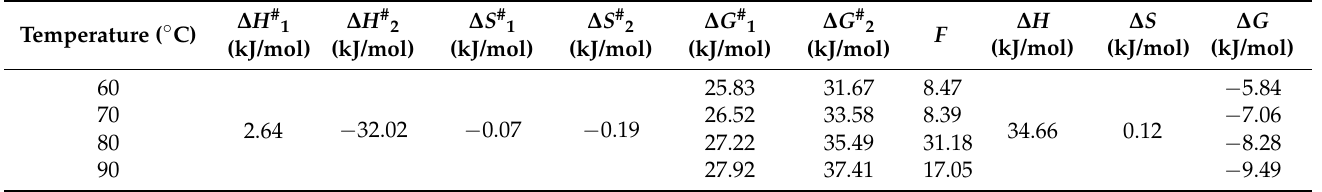
Table 4. Thermodynamic parameters obtained at different temperatures during Haden mango peel pectin extraction. Temperature ( ◦